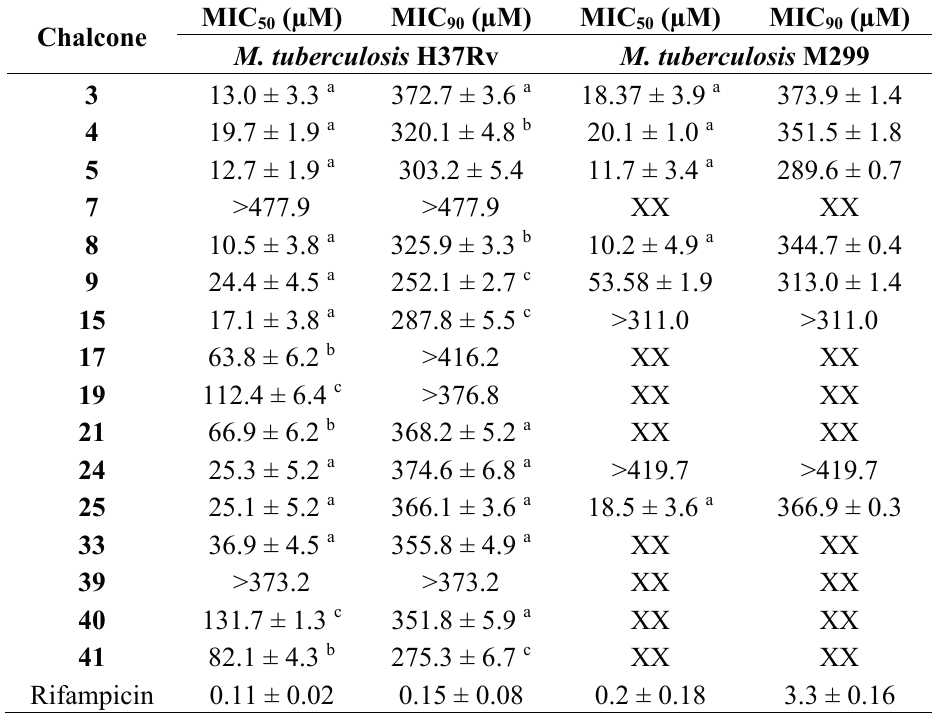
Table 3. Minimum inhibitory concentrations of substituted chalcones suppressing growth of the laboratory M. tuberculosis strain H37Rv and clinical M. tuberculosis isolate